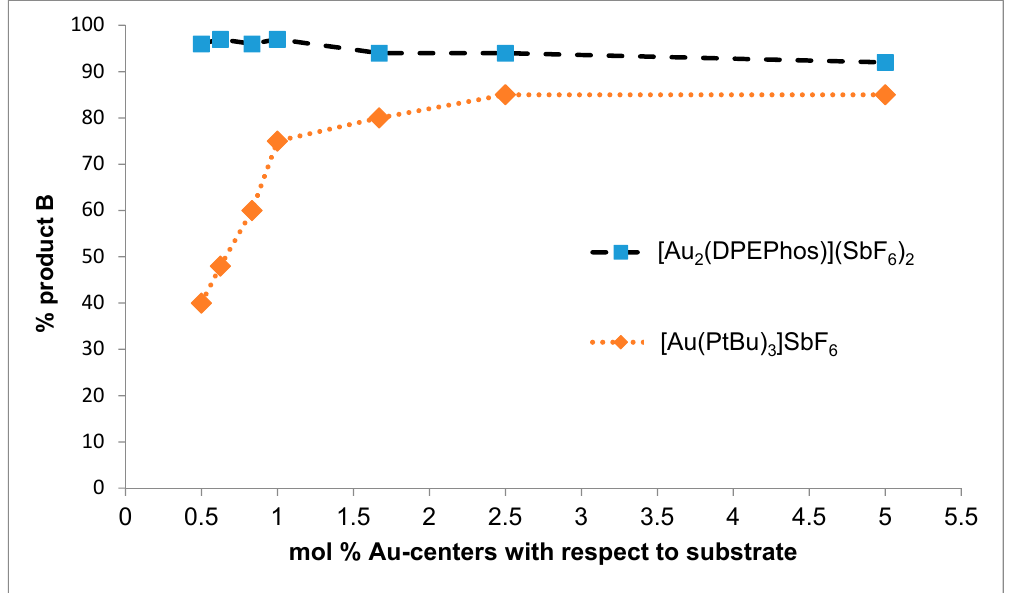
Figure 5. Comparison of regioselectivity to indole B under various dilution conditions, obtained with dinuclear catalyst 4 in the presence of one equiv. of AgSbF 6 vs. mononuclear benchmark AuCl(P t Bu 3 ) with one equiv. AgSbF 6